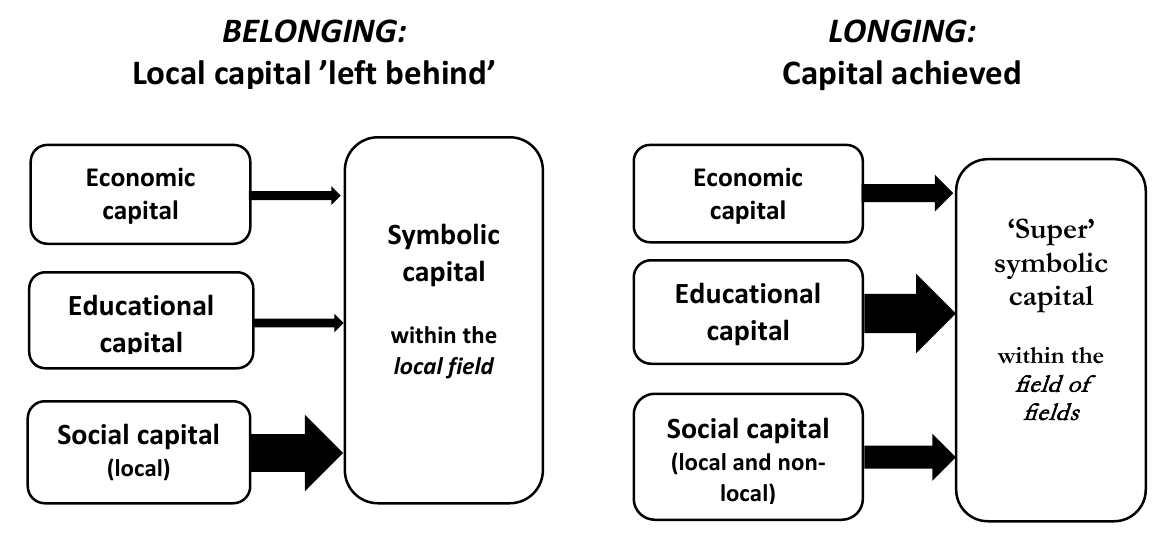
Note: The arrows illustrate the degree of convertibility into symbolic capital. Figure 4. Young rural-to-urban migrants: Local capital ‘left behind’ and capital achieved (model